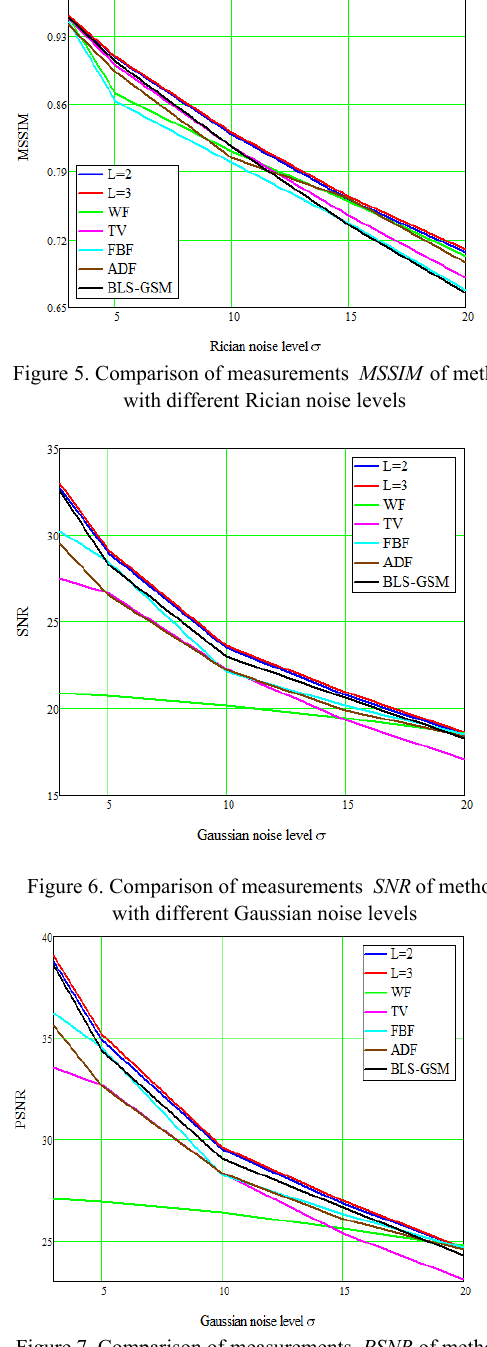
Figure 7. Comparison of measurements PSNR of methods with diffrent Gaussian noise levels